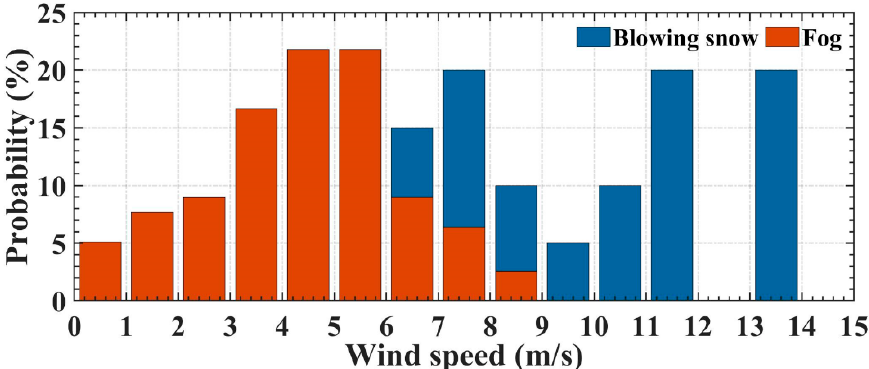
Figure 10. Probability of blowing snow and fog events at different wind speeds with the relative humidity above 90%.